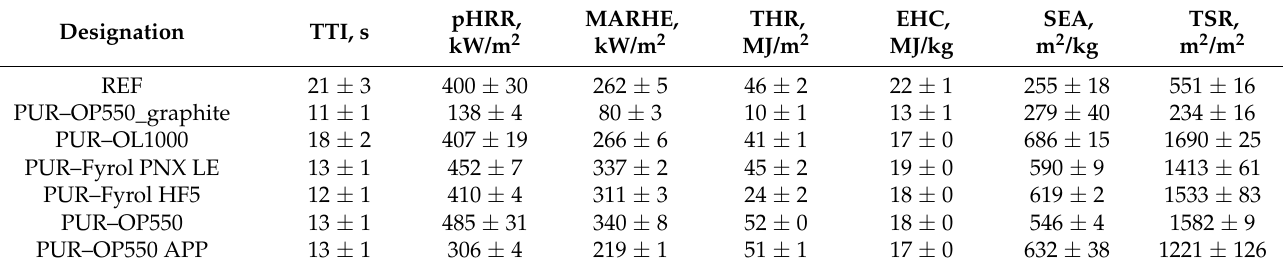
Table 9. Foams burning parameters depending on the flame retardant.